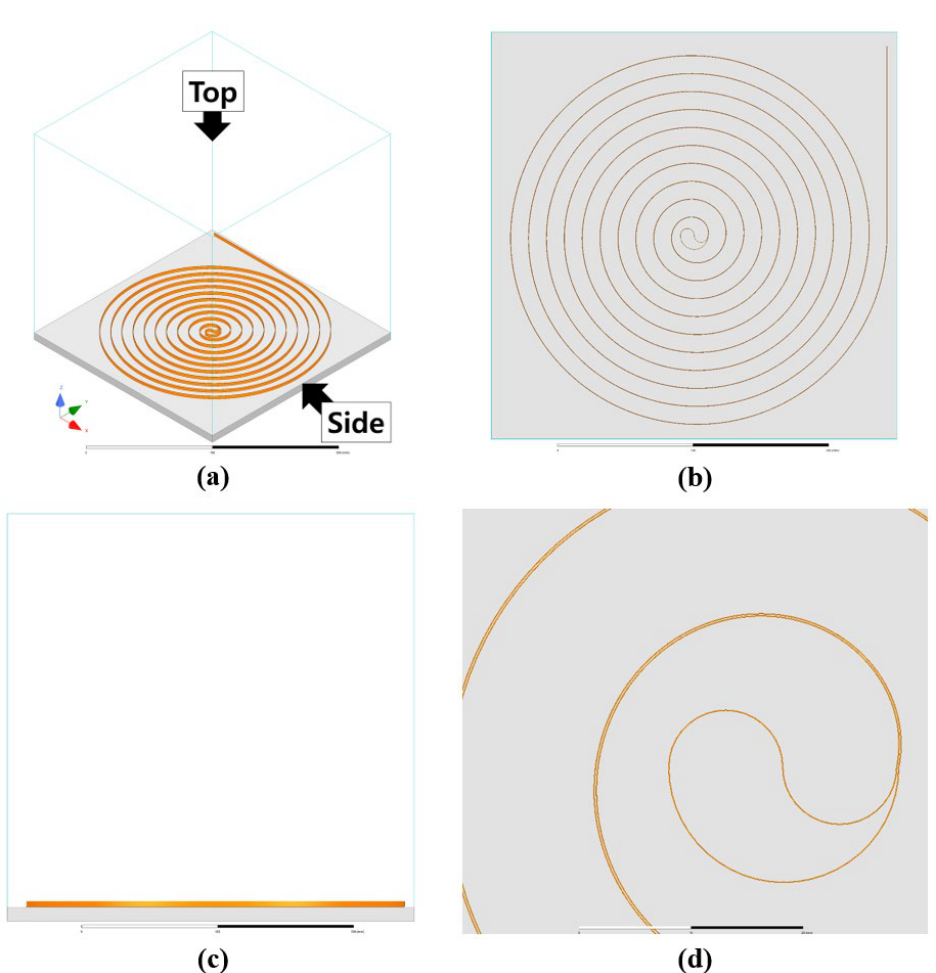
Figure 9. Superconducting module modeling with the bifilar-spiral type: ( a ) overall, ( b ) top view, ( c ) side view, ( d ) bifilar view.